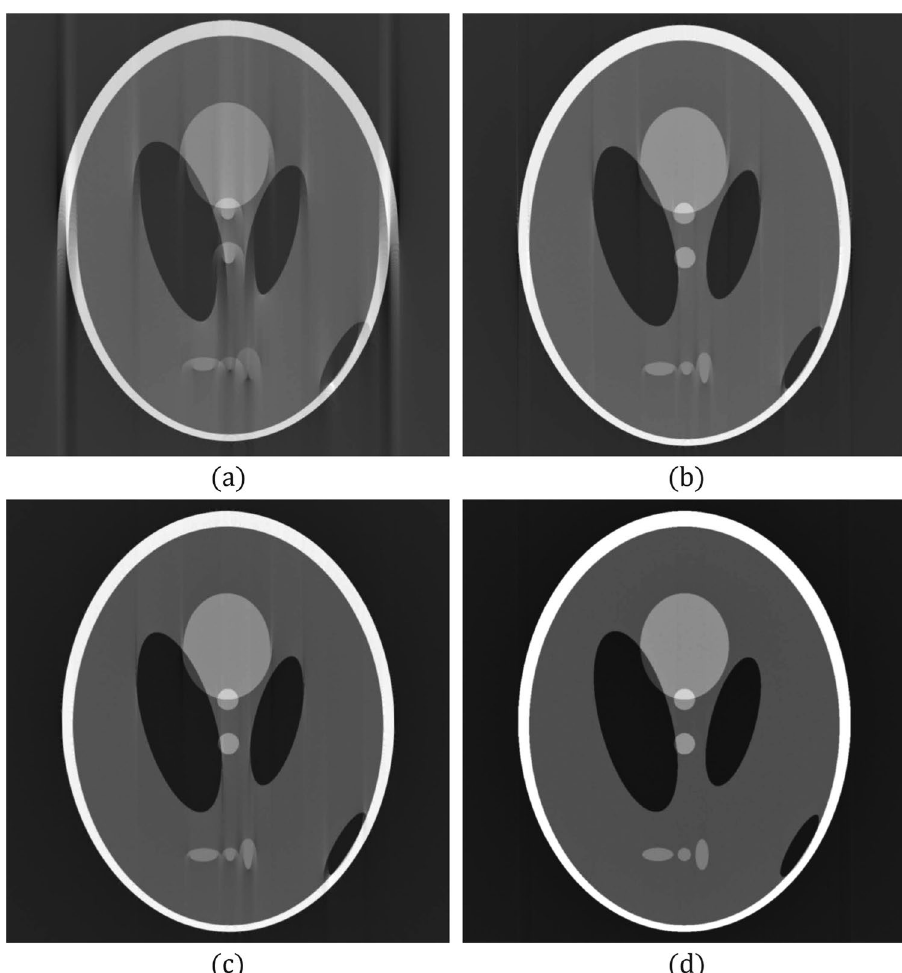
Figure 2. Tomographic images of Phantom 1 reconstructed from 600 projections with 1024 parallel beams. The interval of angle for generating the projections was 0.303° and the projected rotational axis was biased to the right by 10 pixels. ( a ) Reconstruction result without correction of the interval of projection angles or the rotational axis. ( b ) Reconstruction result when δ B was corrected by the ENP method. ( c ) Reconstruction result when δ B was corrected by the FC method. ( d ) Reconstruction result when δ B and θ E were corrected by the proposed